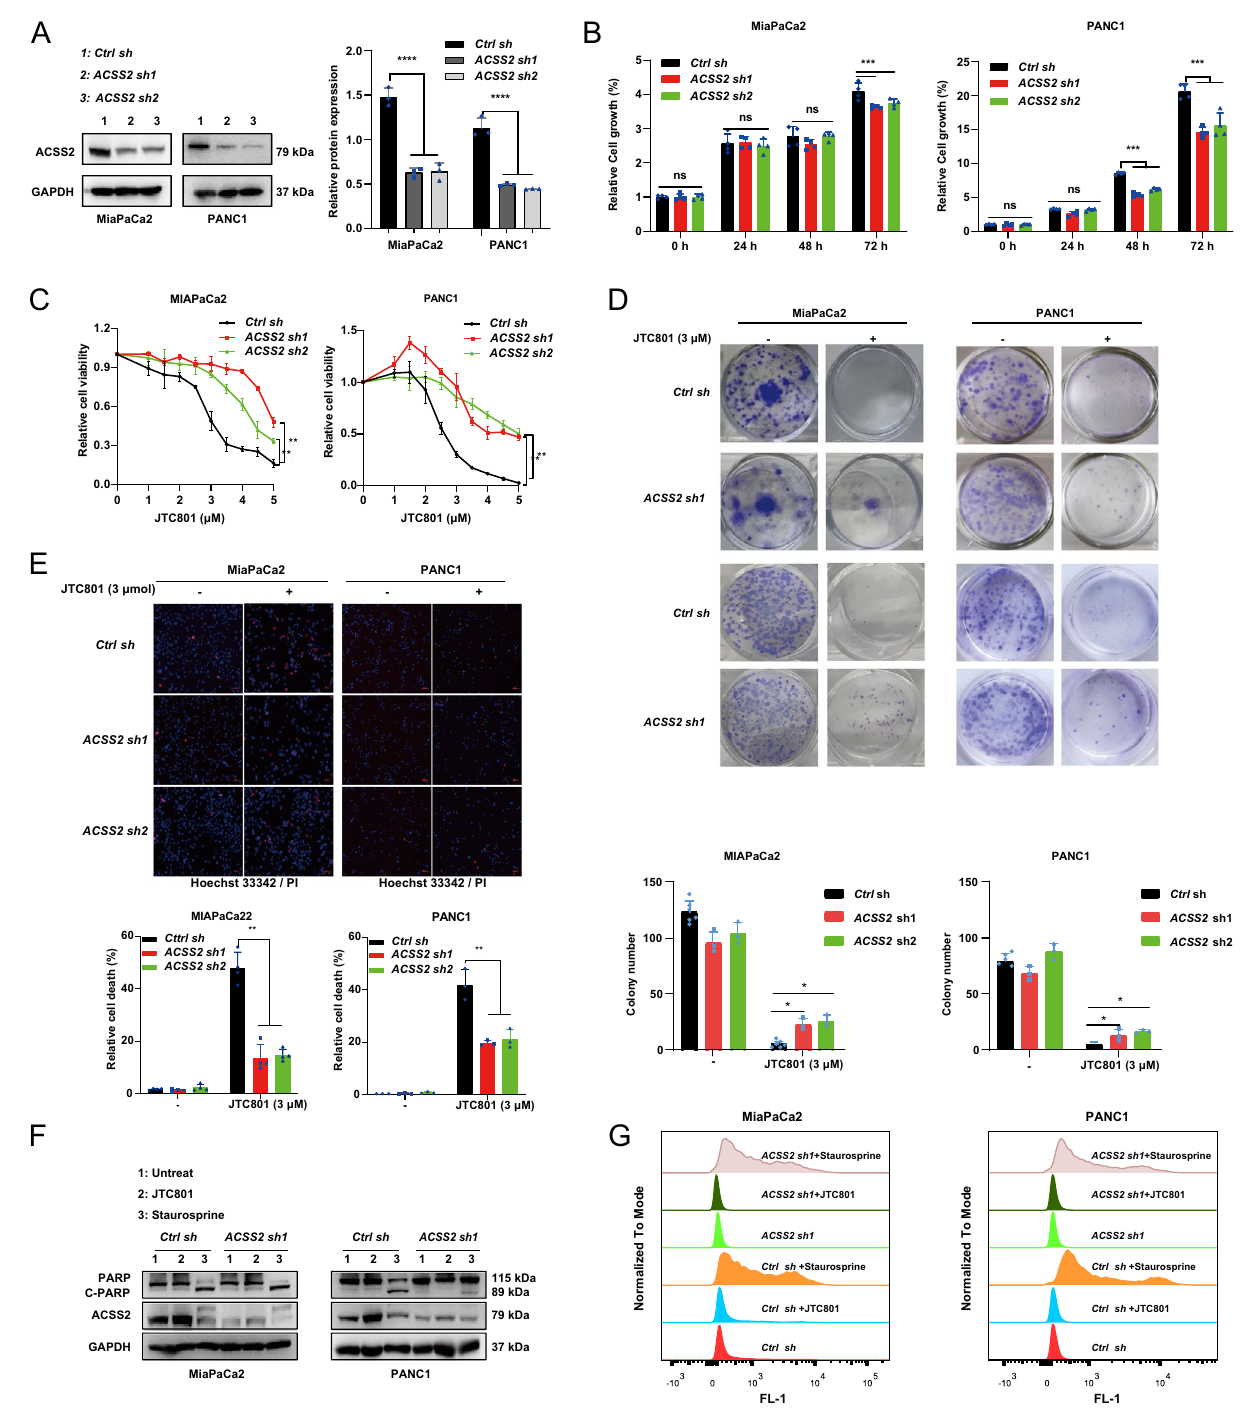
Figure 2. ACSS2 is a positive regulator of alkaliptosis. ( A ) Western blot analysis of ACSS2 protein expression in indicated ACSS2 knockdown cell lines (n = 3 biologically independent samples). The membrane were cropped and probed for indicated antibodies. Quantitative results are plotted in the right panel. ( B ) Analysis of cell viability in indicated cells at 24–72 h (n = 3 biologically independent samples). ( C ) Analysis of cell viability in indicated cells following treatment with JTC801 (1–5 µM) for 24 h (n = 3 biologically independent samples). ( D ) Analysis of cell cloning formation in indicated control or JTC801-treated PANC1 and MiaPaCa2 cells. Quantitative results are plotted in the bottom panel. ( E ) Analysis of cell death by PI staining in indicated cells following treatment with JTC801 (3 µM) for 24 h (n = 3 biologically independent samples). Bar = 200 µm. Quantitative results are plotted in the below panel. ( F ) Western blot analysis of ACSS2 and C-PARP protein expression in indicated cells following treatment with staurosporine (500 nM) or JTC801 (3 µM) for 24 h (n = 3 biologically independent samples). The membrane were cropped and probed for indicated antibodies. The membrane of PARP was stripped and reprobed for ACSS2. The membrane was incubated in reblot solution for 30 min and blocked for 30 min at room temperature with TBST-containing skin milk (5%) and probed overnight at 4 °C with anti-ACSS2 (Restore™ PLUS Western Blot Stripping Buffer, 46430, Thermo Scientific). ( G ) Flow cytometeric analysis of Caspase 3/7 activity in indicated cells following treatment with staurosporine (500 nM) or JTC801 (3 µM) for 24 h (n = 3 biologically independent